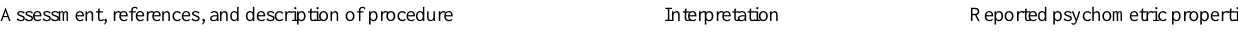
Internal consistency=0.52; Corre- version=0.87Symptoms scored according to lation with long self-rated